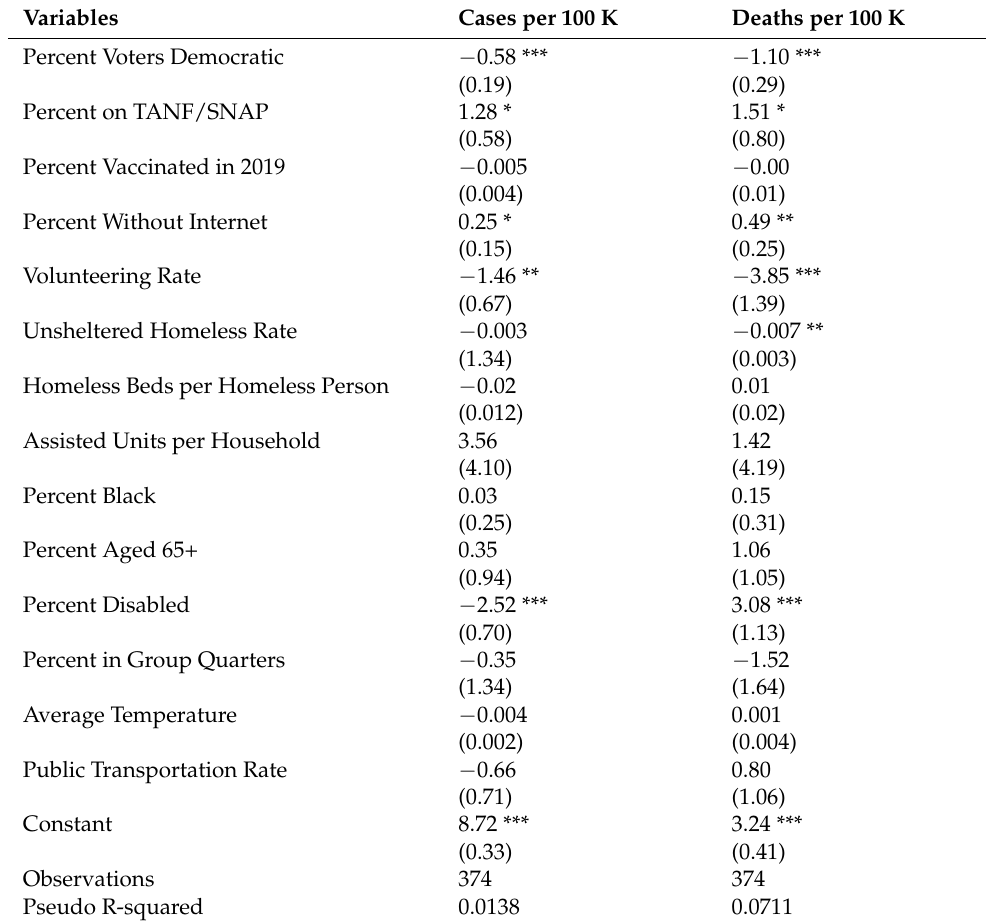
Table 2. Regression Coefficients (Standard Errors) on Cumulative COVID-19 Cases and Deaths. (as of 30 April